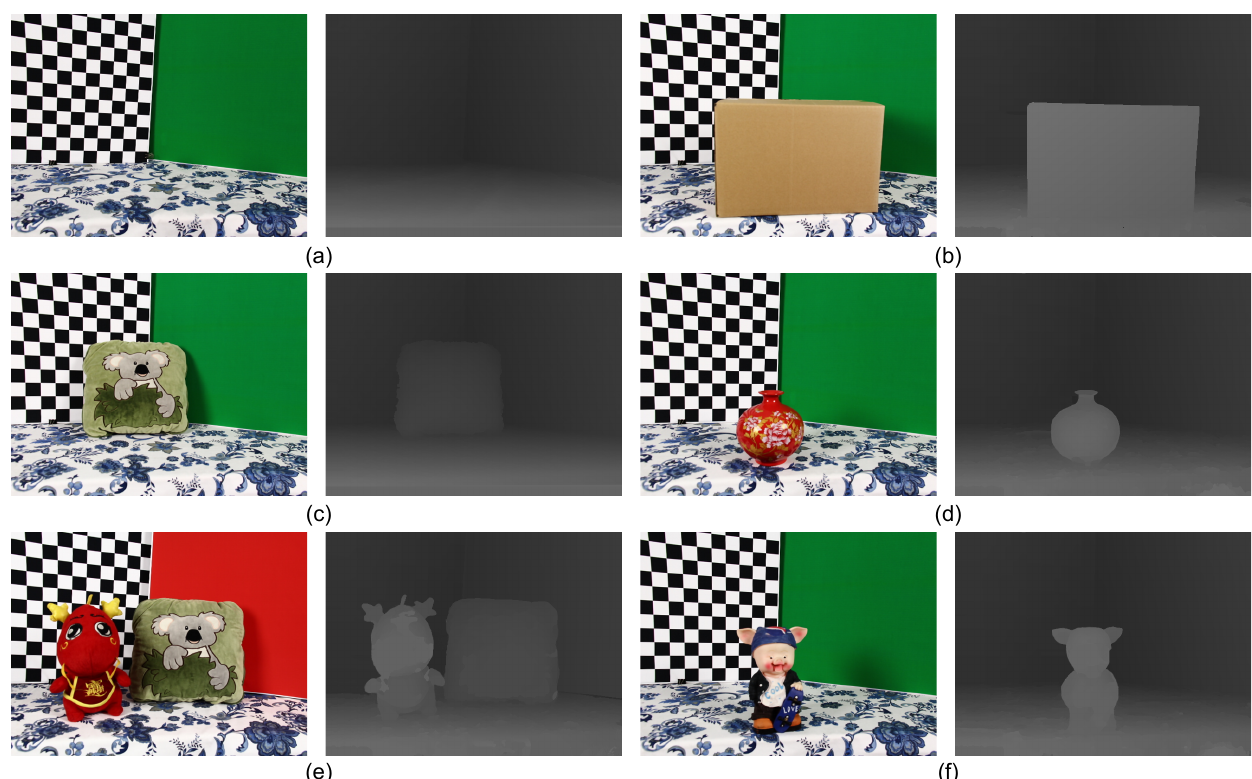
Figure 8. Comparative results for different real-world scenes: ( a ) Board; ( b ) Box; ( c ) Kola; ( d ) Vase; ( e ) Dragon and Kola; ( f ) Piggy. All scenes were approximately 0 . 5 – 1 . 5 m from the cameras, and the maximum disparity was 107 pixels. Each scene from left to right contains the rectified left image and its associated result of our